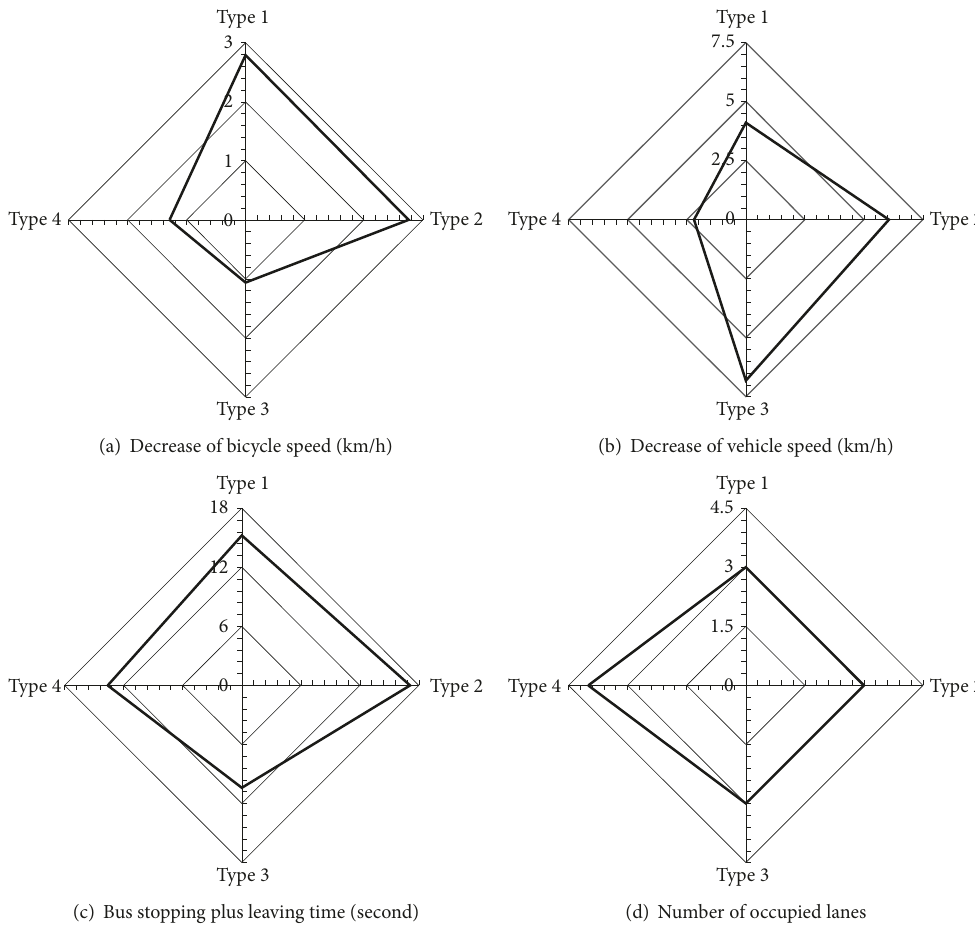
Figure 7: Summary of impacts of different bus stops